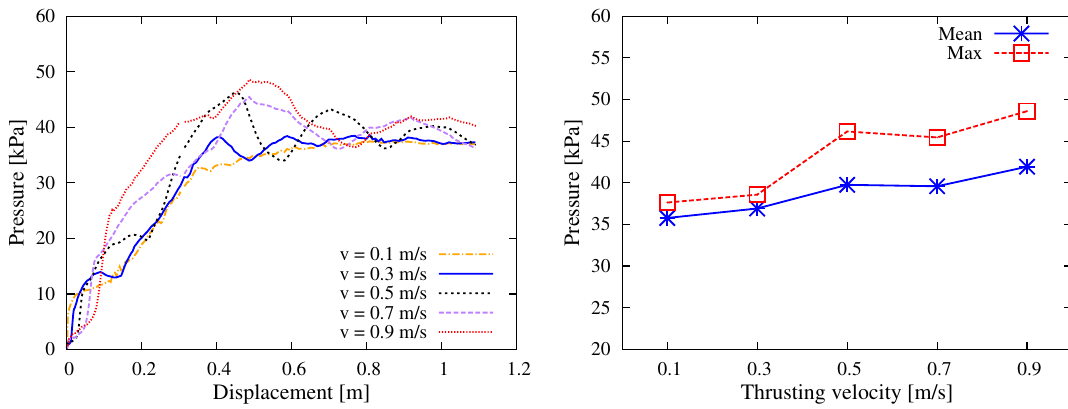
Figure 16. Simulation results with respect to the pumping velocity: ( left ) curves of the thrusting pressure vs. displacement relationship; and ( right ) mean and max values during the stable pumping stage.